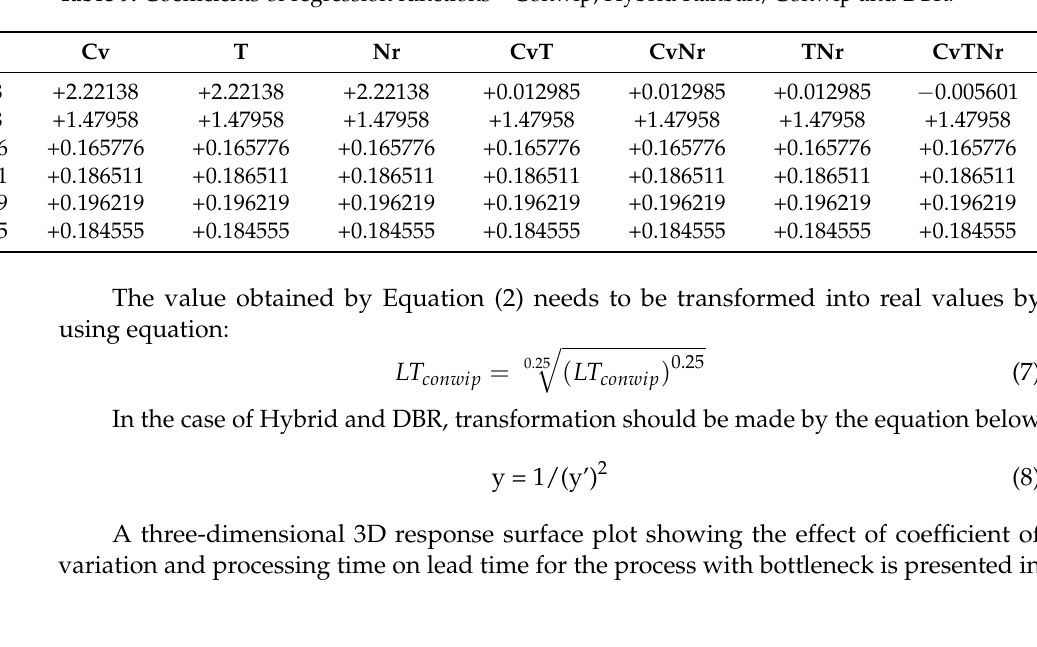
Table 9. Coefficients of regression functions—Conwip, Hybrid Kanban/Conwip and